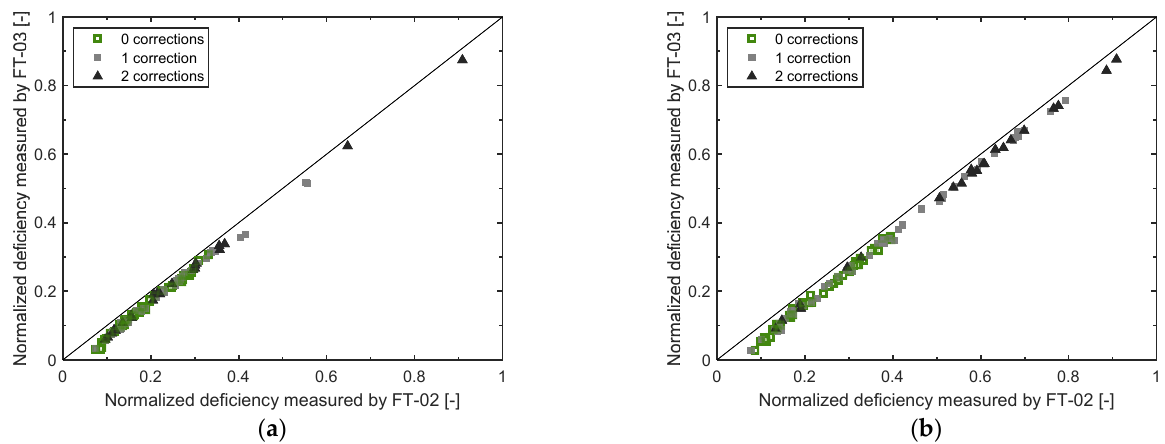
Figure 11. Schematic representation of the main equipment and instrumentation involved in the feeding of reactant D to R201.